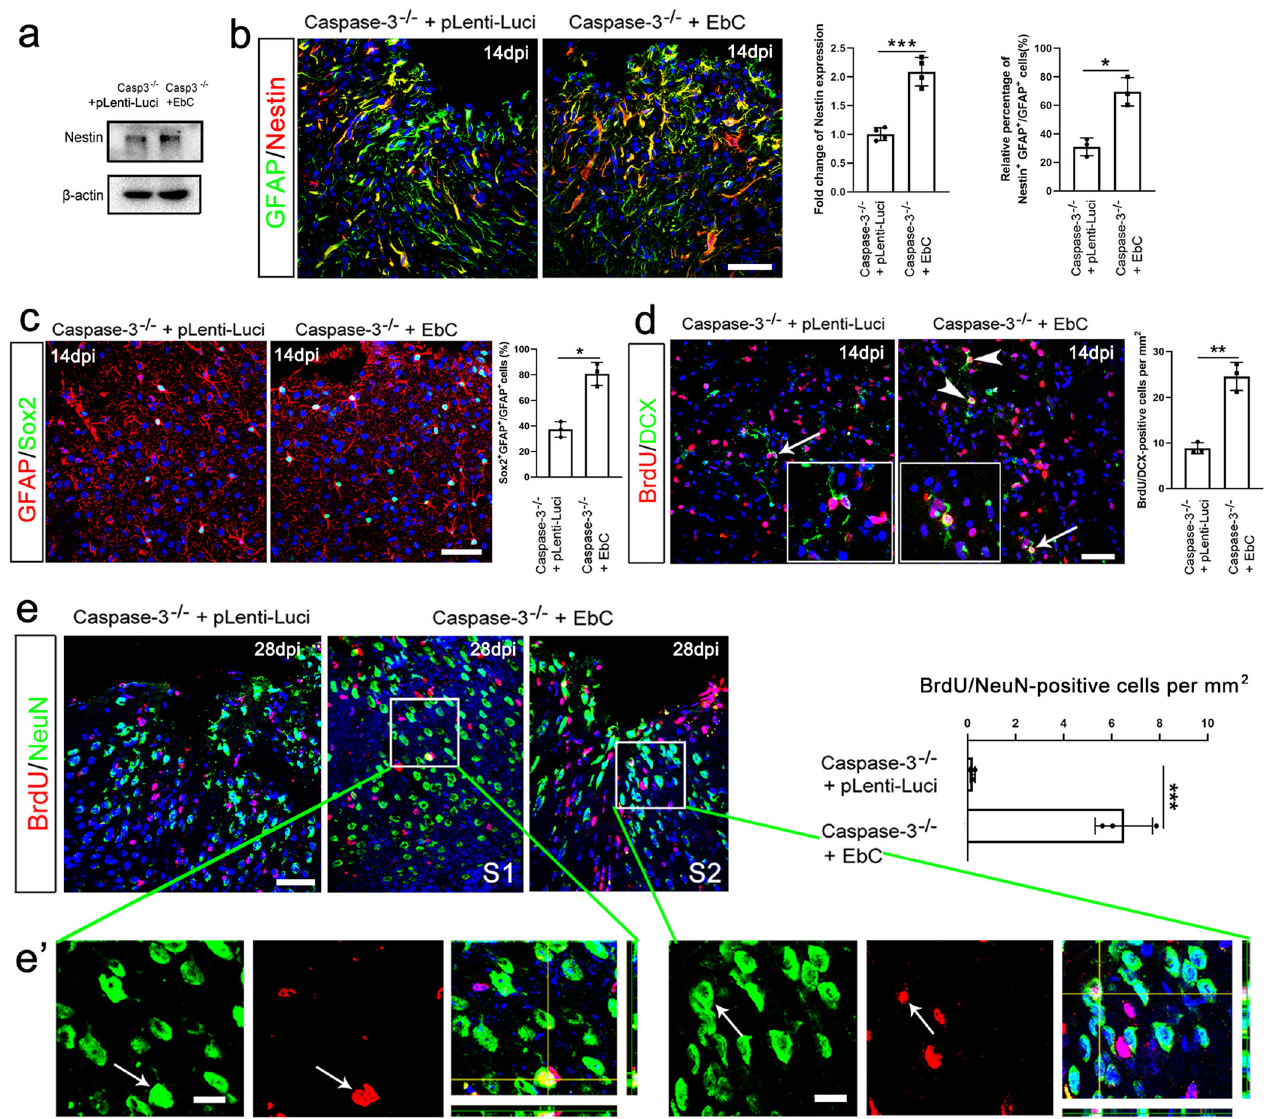
Fig. 6 Restoration of astrocyte dedifferentiation and promotion of neurogenesis in caspase-3-de fi cient cortex by stabilized β -catenin. a Western-blotting of Nestin in ischemic caspase-3 − / − cortex infected by lpLenti-Luci (control) or EbC. b Immunostaining of GFAP/Nestin in ischemic caspase-3 − / − cortex infected by pLenti-Luci (control) or EbC. *** P = 0.0009 (left panel), * P = 0.0193 (right panel). Two-tailed Student ’ s t test. N = 3 – 4 mice per group. c Immunostaining of GFAP/Sox2 in ischemic caspase-3 − / − cortex infected by pLenti-Luci (control) or EbC. * P = 0.0372. Two-tailed Student ’ s t test. N = 3 mice per group. d Representative images and quanti fi cation of BrdU/DCX double immunostaining in ischemic caspase-3 − / − cortex infected by pLenti-Luci (control) or EbC. EbC signi fi cantly increases the number of GFAP/ Sox2- and BrdU/DCX-double positive cells. Arrowheads point to double-positive cells and arrows point to magni fi ed cells. Bar = 30 μ m. ** P = 0.0063. Two-tailed Student ’ s t test. N = 3 mice per group. e Double immunostaining and quanti fi cation of BrdU/NeuN -positive cells in ischemic caspase-3-de fi cient cortex infected with control virus or EbC. There is approximately one BrdU/NeuN-positive cell on average per section of EbC treated cortex. S1, section 1. S2, section 2. Bars = 30 μ m in ( e ), 5 μ m in ( e ). Arrows point to BrdU/NeuN-positive cells. *** P < 0.001. Two-tailed Student ’ s t test. N = 3 per group. Mean ± standard error (SE). Asterisks with bars connecting two groups indicate difference between these two